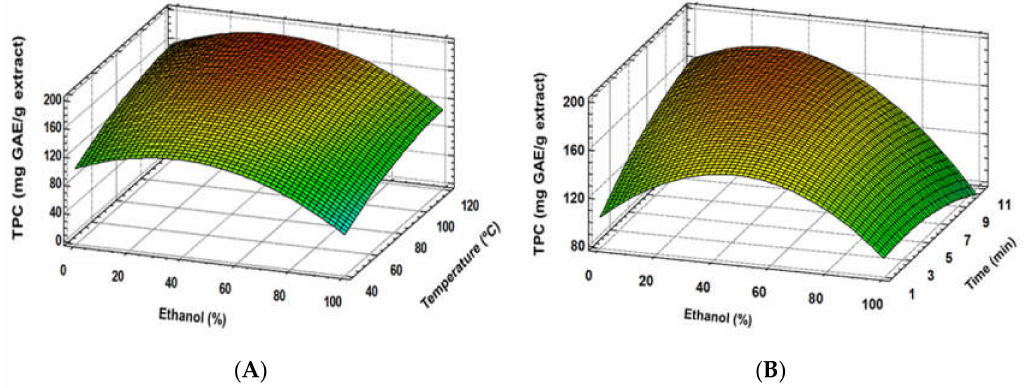
Figure 2. Response surface plots of the TPC as a ff ected by independent factor; ethanol (%) vs . temperature ( A ), ethanol (%) vs . time ( B ).